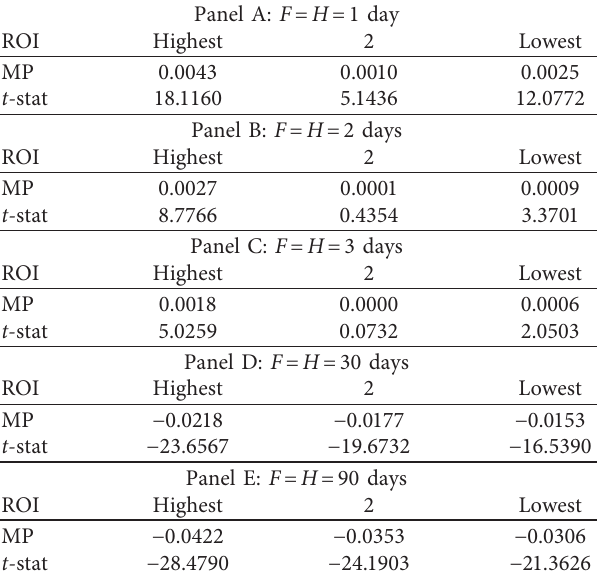
Table 9: The effect of the accumulative relative order imbalance: three